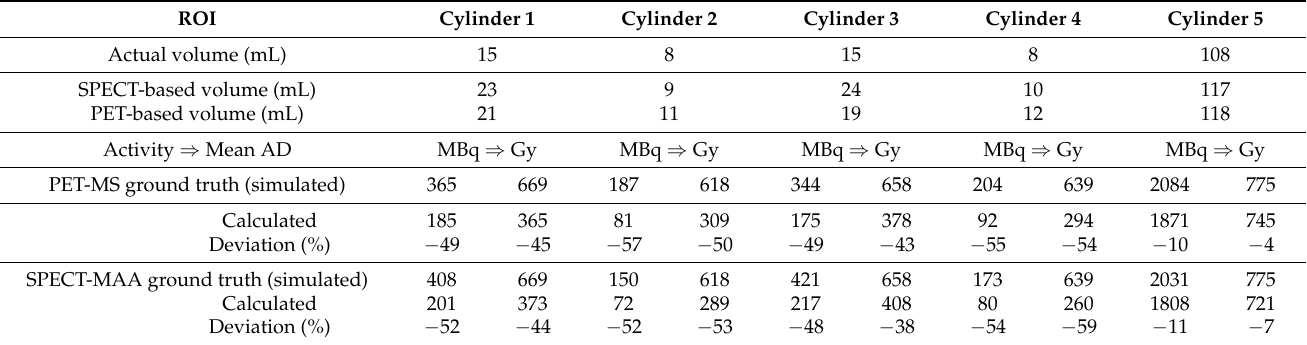
Table 2. Accuracy of SPECT-MAA and PET-MS based recovered activity and derived ADD. For